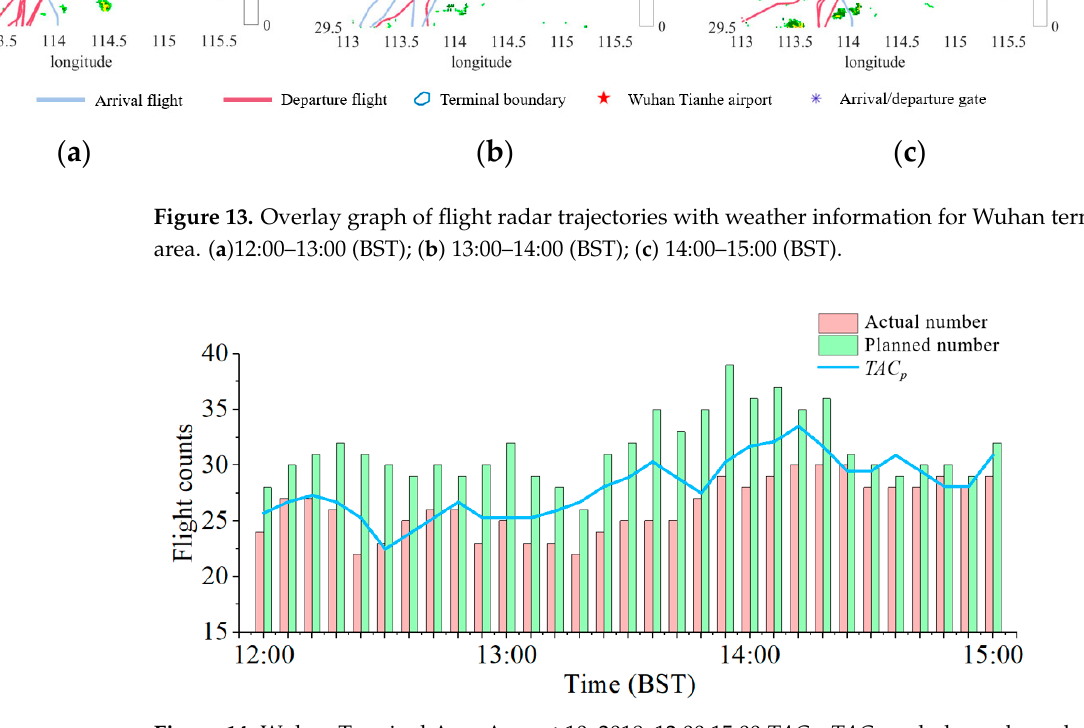
Figure 14. Wuhan Terminal Area August 10, 2018, 12:00 15:00 TAC p , TAC r and planned number.